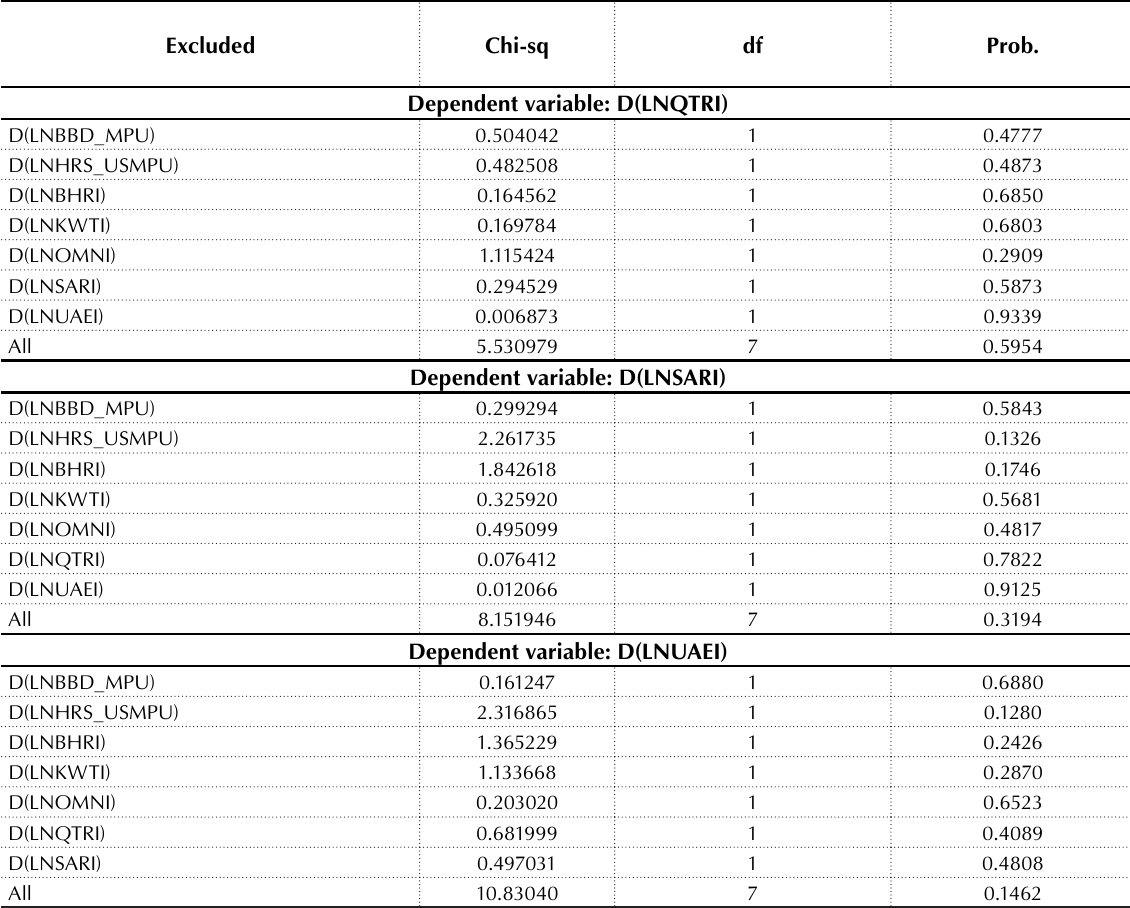
Table A4 (cont.). Block exogeneity